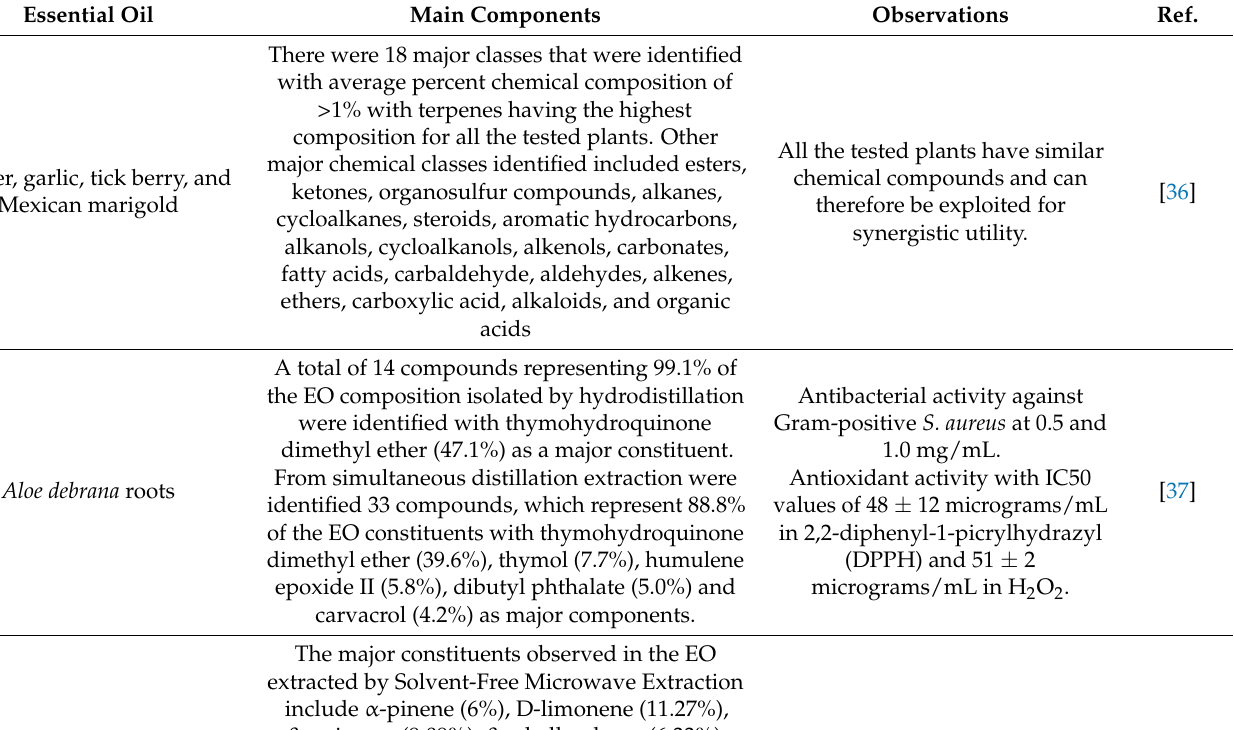
Table 1. Main constituents of some